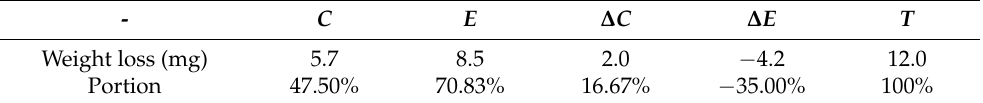
Table 2. Weight loss and portion of the pure corrosion, pure erosion and synergism.